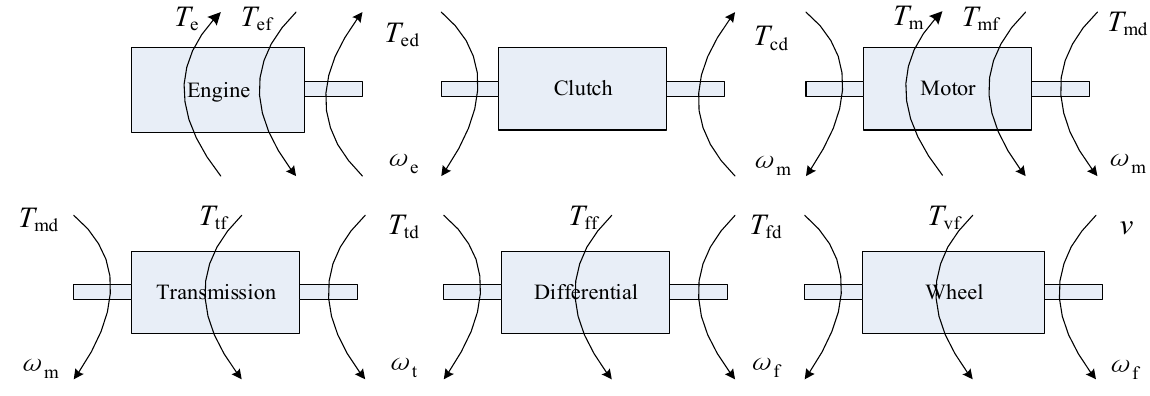
Figure 2. Input and output variables in dynamic system.